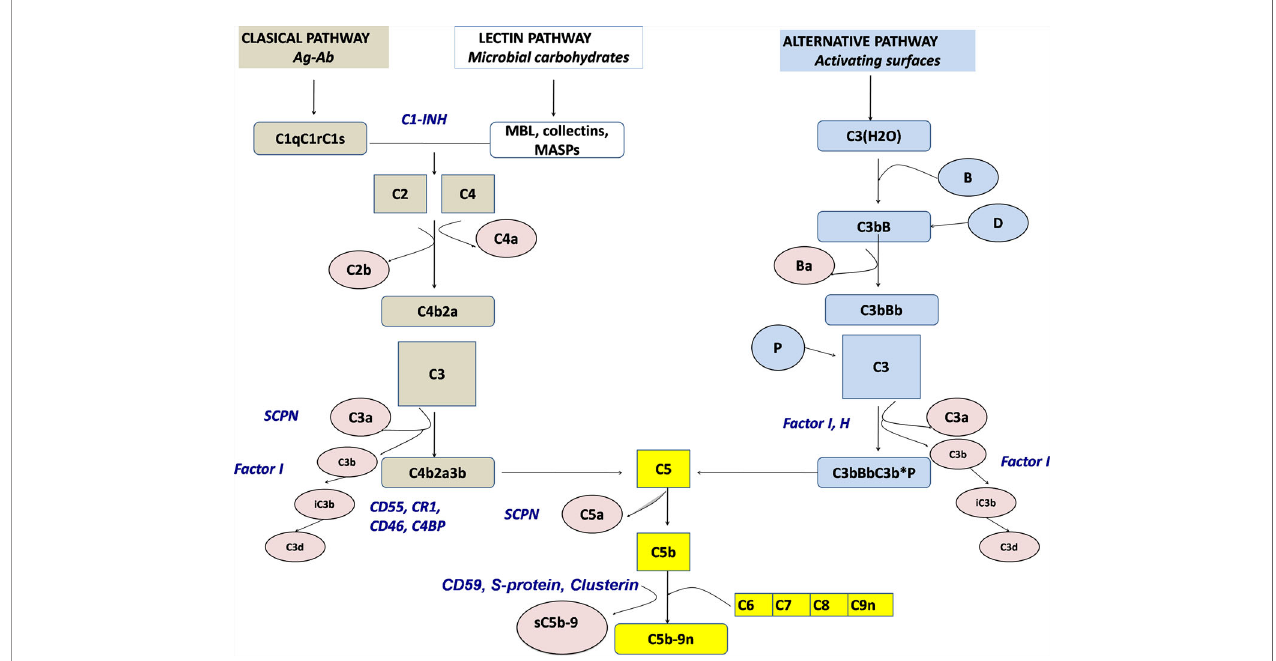
FIGURE 1 | Schematic representation of the complement activation pathways (brown: classical pathway, white: lectin pathway, light blue: alternative pathway, yellow: terminal pathway). Activation products, released into the fl uid phase are presented in rose, whereas regulators are presented by blue. SCPN, serum carboxypeptidase N; MBL, mannose-binding